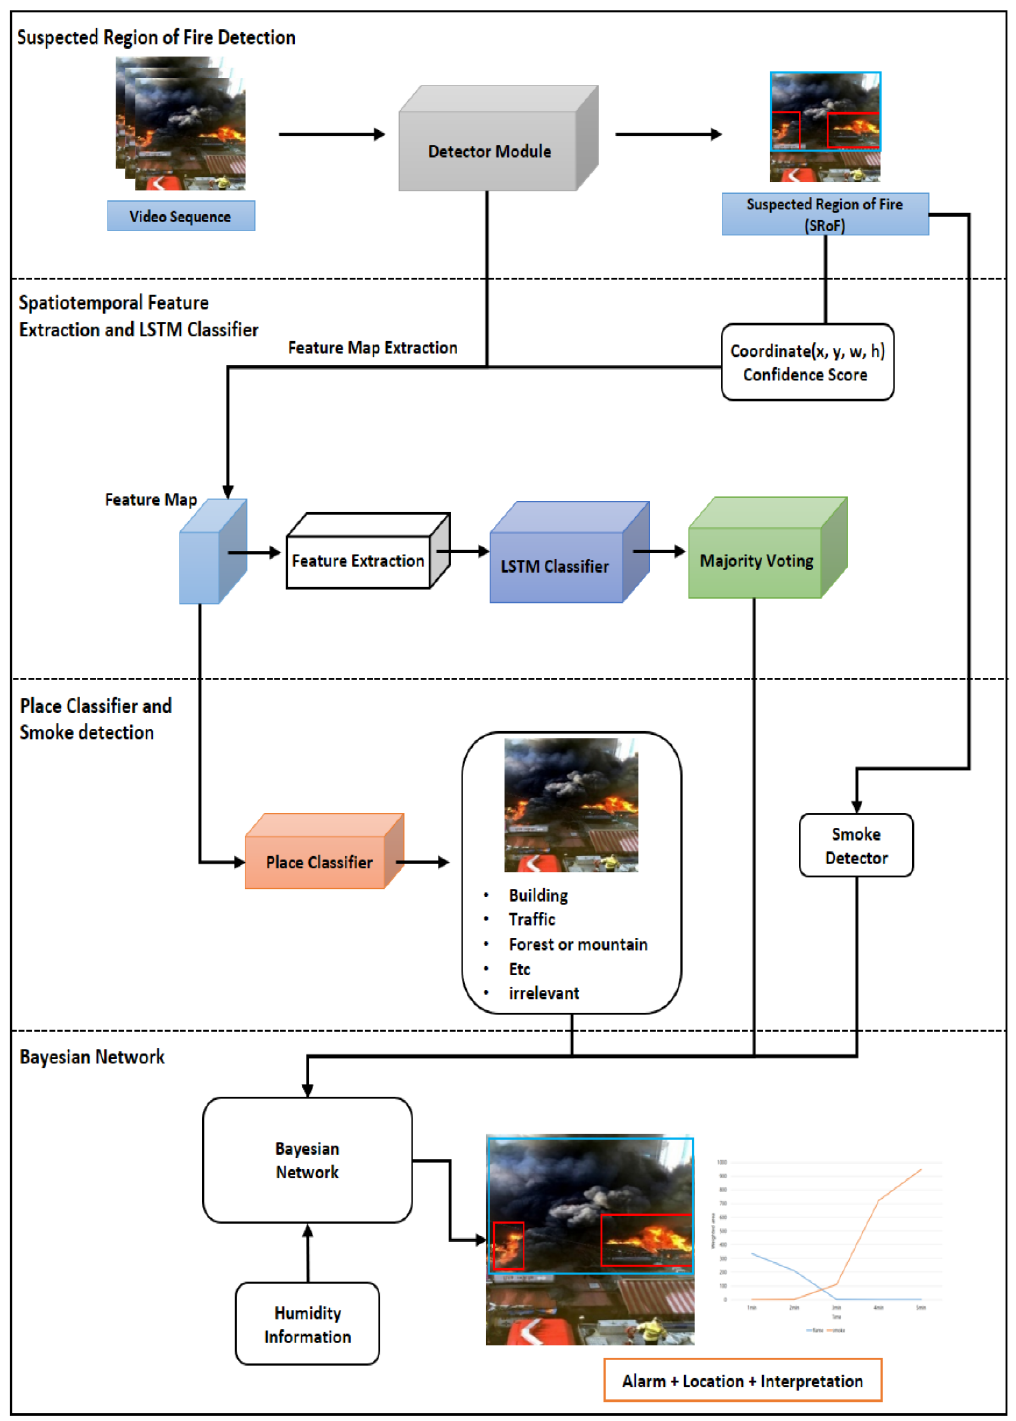
Figure 1. The proposed network architecture [26].